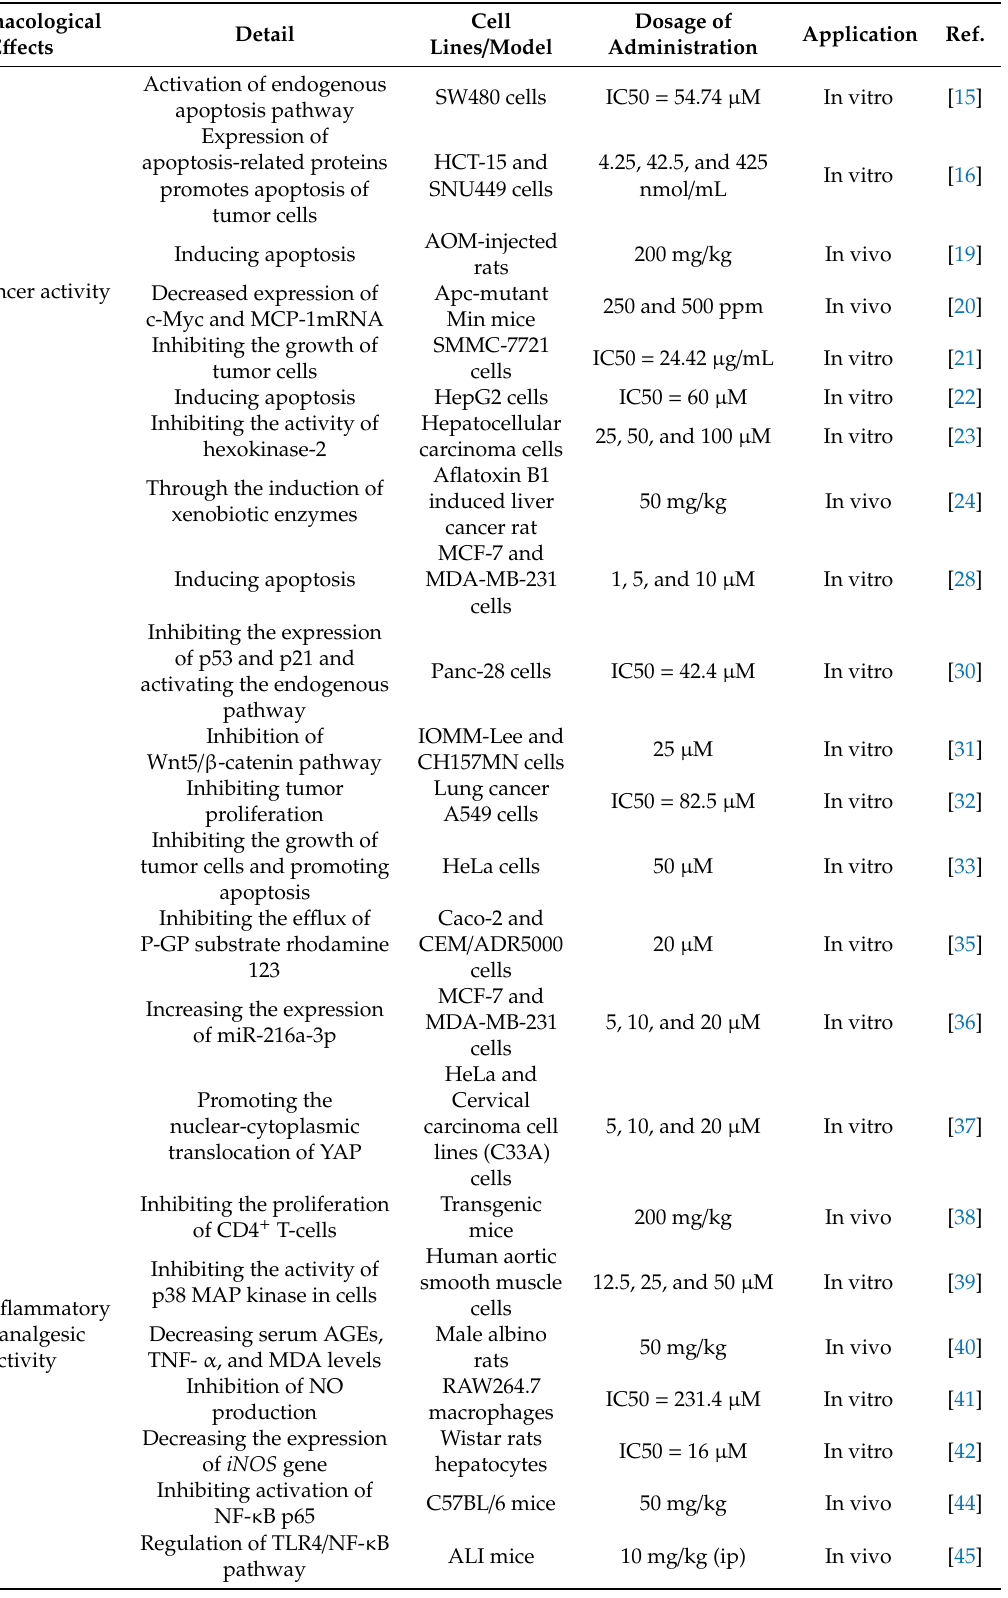
Table 2. Biological and pharmacological activities of limonin—in vitro and in vivo studies summary.